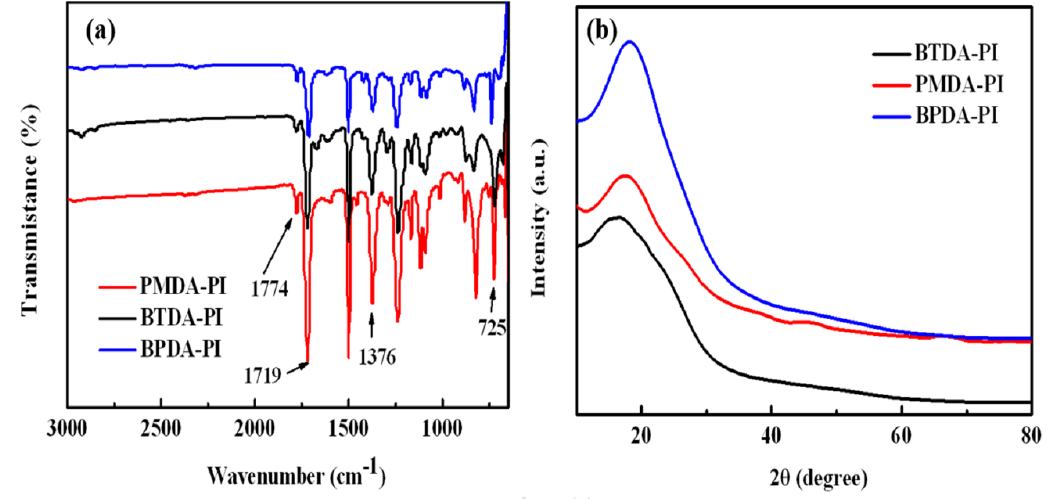
Figure 2. FT-IR spectra ( a ) and XRD patterns ( b ) of PI films.